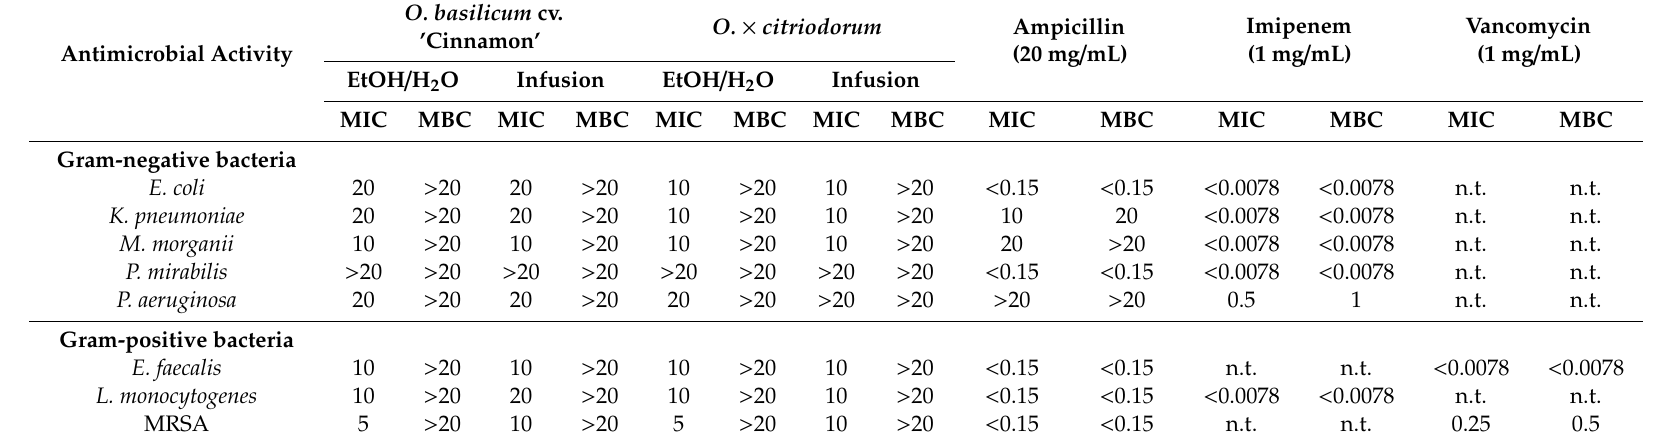
Table 4. Antimicrobial activity of the extracts obtained from the basil samples (mg / mL, mean ± SD, n = 3).